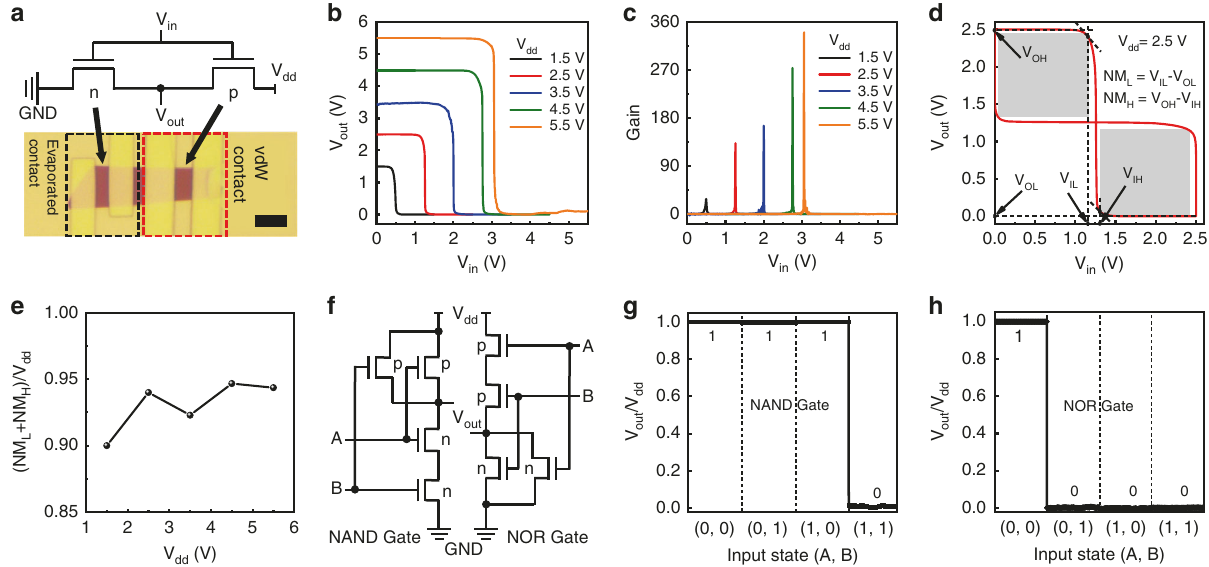
Fig. 4 CMOS logic functions based on WSe 2 transistors with different contact approaches. a Circuit diagram (upper) and optical image of a typical complementary inverter composed of two WSe 2 transistors in series, where one is contacted with deposited Au electrodes (n-type) and another is contacted by vdW Au electrodes (p-type). Scale bar in the optical image is 4 μ m. b The voltage transfer characteristics of the inverter as a function of the input voltage with different V dd from 1.5 to 5.5 V (1-V step). c The corresponding voltage gains of the resulting inverter. d The bistable hysteresis voltage transfer characteristics of WSe 2 CMOS logic inverter as a function of the input voltage ( V dd = 2.5 V), with the noise margin low (NM L ) of 1.16 V and noise margin high (NM H ) of 1.19 V achieved. The V OH , V OL , V IL , and V IH represent the minimum high output voltage, maximum low output voltage, maximum low input voltage, and minimum high input voltage for the inverter, respectively. e The ratio of the total noise margin as a function of V dd . f NAND and NOR circuit diagram composed of four WSe 2 transistors, where two are contacted with deposited Au electrodes as n-type devices, and another two are contacted by vdW electrodes (p-type). g , h The input – output logic functions of NAND ( g ) and NOR ( h ) circuits. Gate voltage of − 30 and 0 V is used as input “ 0 ” and “ 1 ” , respectively. V ds bias voltage is fi xed at 0.23